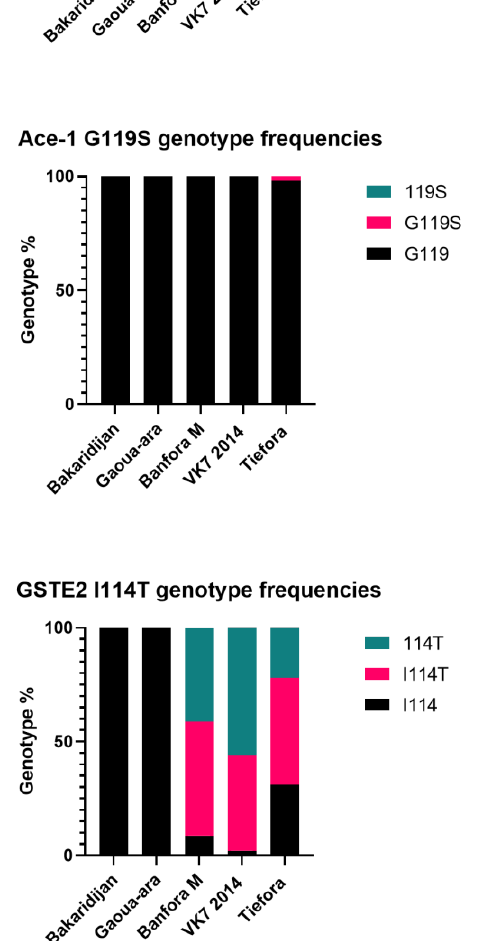
Figure 6. Frequency of point mutations associated with resistance. Data reported from samples genotyped in 2019. 995L, 1575N, 119G, 269A and 114I indicate the wildtype genotype (black bars); 995F, 995S, 1570Y, 119S, 296S and 114T indicate resistant genotype (green or purple bars). Heterozygote genotypes are shown with pink bars.